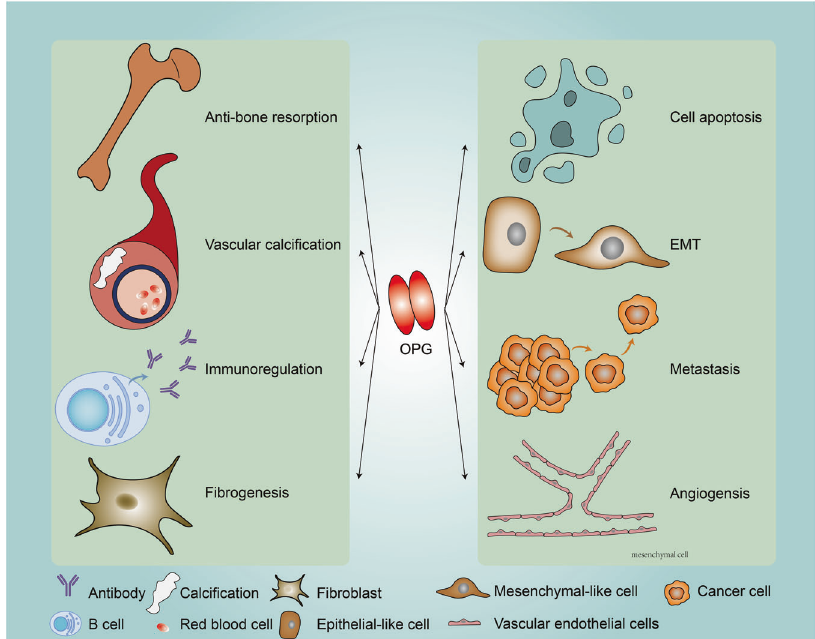
Fig. 3 Summary of the role of OPG in benign and malignant diseases. OPG is involved in various physiological and pathological steps for disease progression, including bone remodeling, vascular calci fi cation, angiogenesis, immunoregulation, fi brosis, cell survival and apoptosis, EMT, and cancer